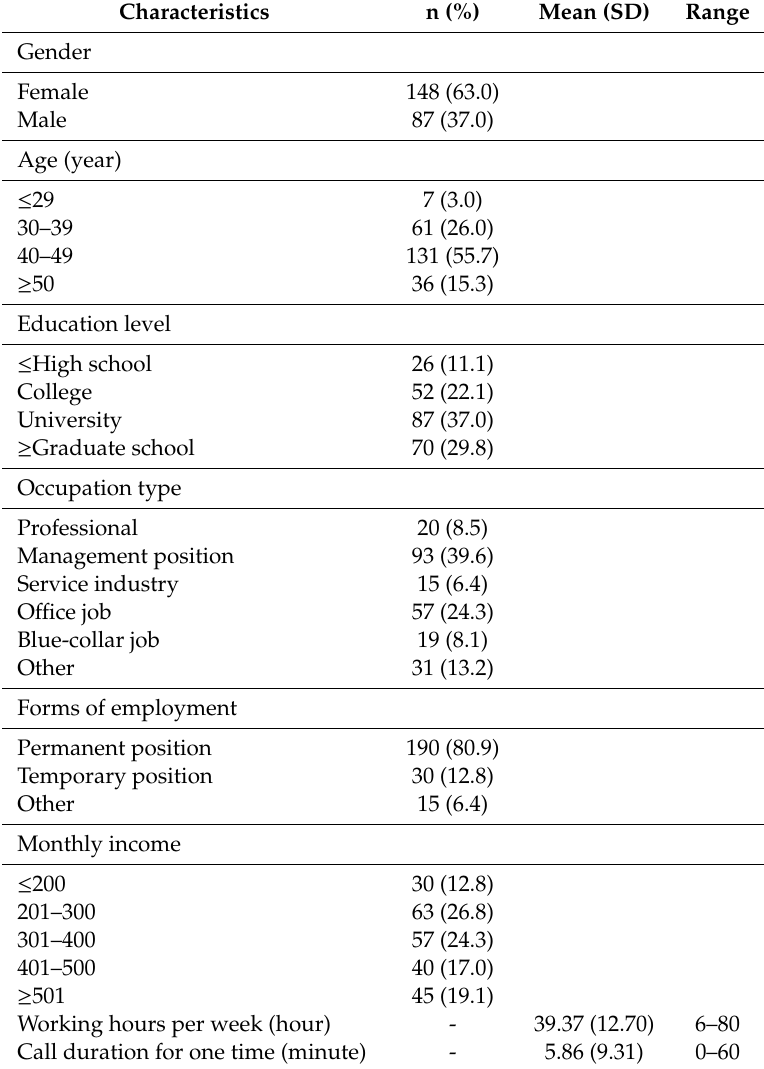
Table 1. General characteristics of the study